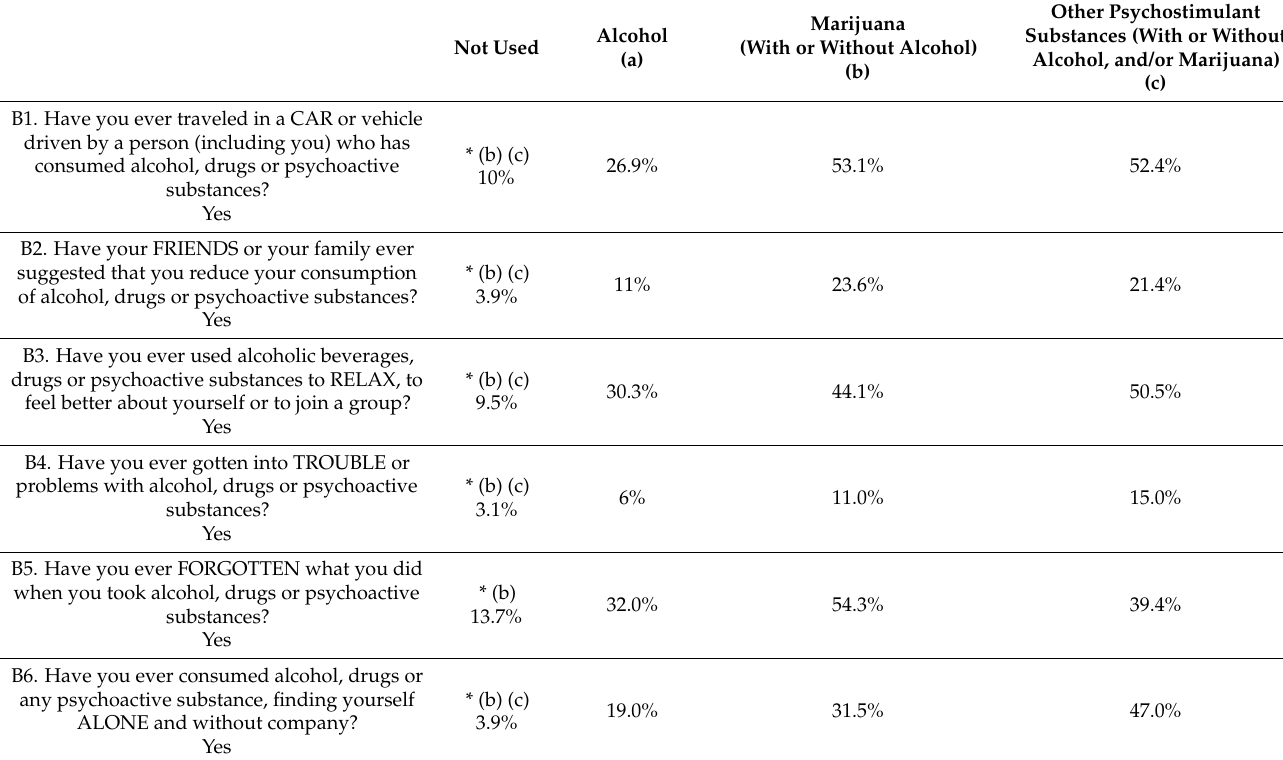
Table 4. Social consequences according to the substance